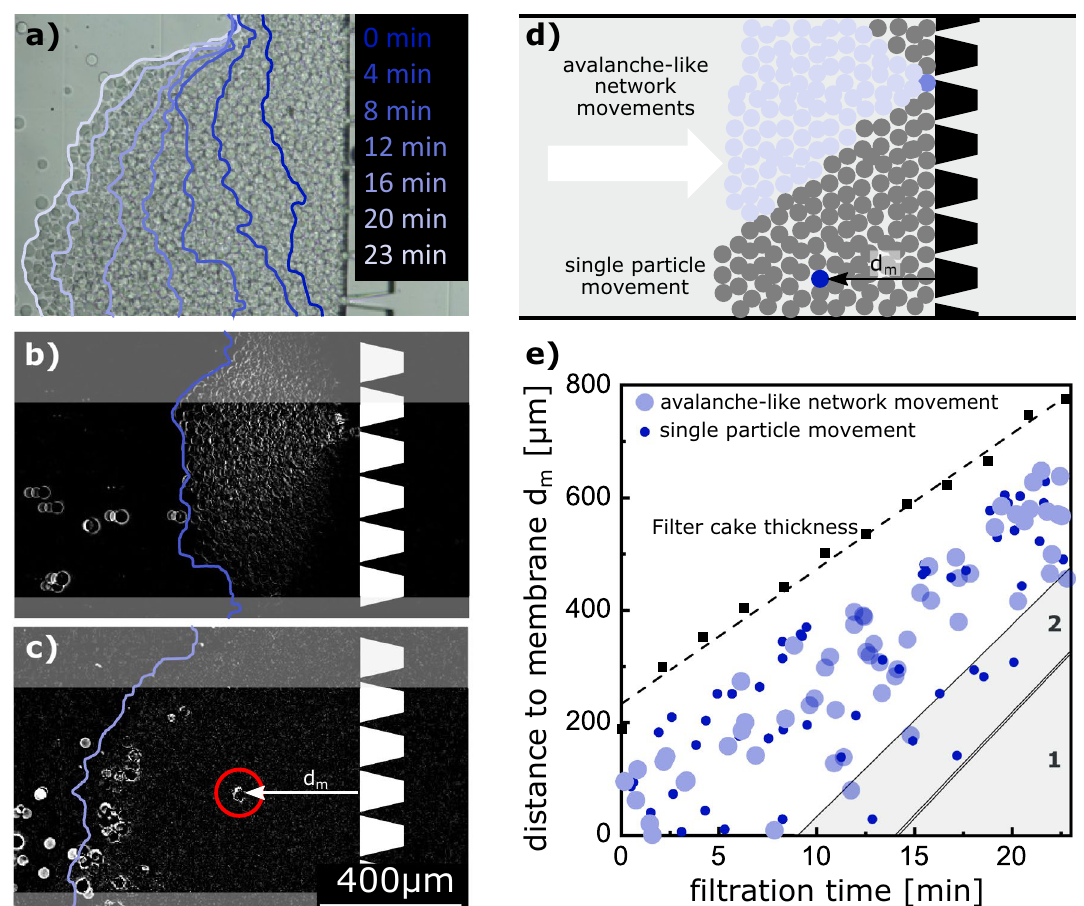
Figure 1. Evolution of a filter cake of 27 µ m sized PEG microgels inside a microfluidic PDMS channel during constant pressure filtration. The lines in ( a ) indicate the cake surface at the respective time. Visualization of the local cake movements by microgel rearrangement with avalanche-like network movements ( b ), and single- particle movements ( c ). We overlaid the filter cake surface at that respective time as a blue line and the porous filtration structure in white for better orientation. Illustration of the two types of rearrangement occurring in the filter cake ( d ). Position of the rearrangements (blue dots) in the filter cake at the respective filtration time and the filter cake thickness (black squares) ( e